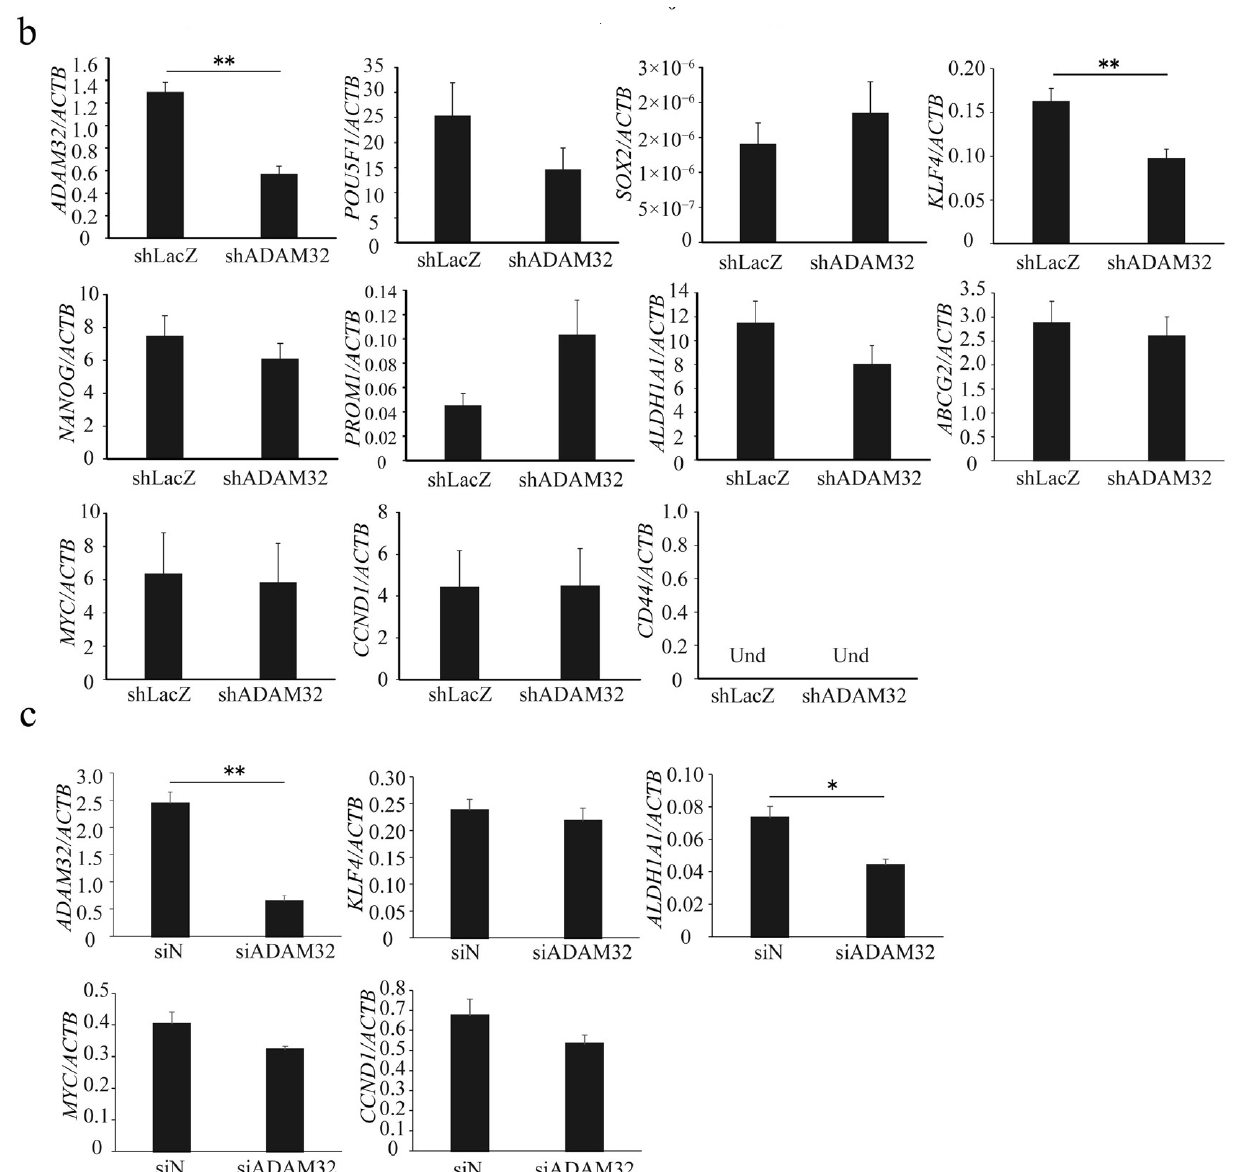
Figure 3. ADAM32 increases expression levels of stem cell-related genes. The expression levels were evaluated with real-time RT-PCR by using total RNA prepared from ( a ) HepG2 Tet treated without or with Dox, ( b ) HepG2, and ( c ) HBCs transiently transfected with shRNA or siRNA and incubated for 48 h. Relative gene expression levels were calculated as the ratio relative to ACTB levels. Values are summarized by mean and SE (n = 3); * p < 0.05; ** p < 0.01; Und, undetermined.